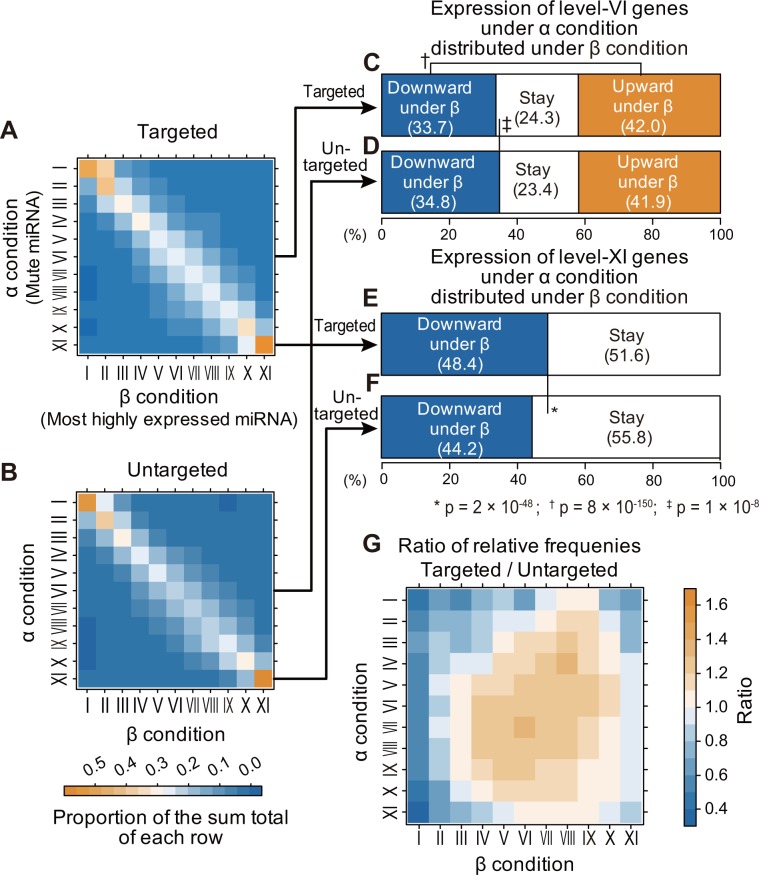
Comparison of target gene expression intensity between conditions of mute miRNA and most highly expressed miRNA.(A, B) Each color-coded matrix is constituted so that each row corresponds to the target gene expression level under the α condition, and each column corresponds to that under the β condition; under the α condition, the expression level of the miRNA that targets the gene is mute, while under the β condition, it is at the highest rank. The elements of each row of the matrix (A) indicate how the expression level of the targeted genes is distributed over the expression level under the β condition using its value as a proportion of the sum total of the row. Thus, the diagonal element indicates the fraction of the targeted genes whose expression level is the same between the β condition and the α condition for each row. Matrix (B) shows the relationship of the expression level of the untargeted genes between the α and β conditions in the same way as in (A). (C) Bar chart showing how the targeted genes of level VI under the α condition are distributed over the levels under the β condition with the fractions of three categories: downward shift in expression level under β, here denoted as DSuβ (downward shift under β), staying the same, and upward shift in expression level under β. (D) For the untargeted genes, the bar chart is shown in the same way as in (C). (E) Bar chart indicating how the targeted genes of level XI under the α condition are distributed over the levels under the β condition with the fractions of two categories, namely, DSuβ and staying the same. (F) For the untargeted genes, the bar chart is shown in the same way as in (E). (G) The matrix indicates the ratio of the relative frequency of targeting occurrences for (true) targeted genes to that for (background) untargeted genes. This was computed for each combination of α and β (see also Materials and Methods).